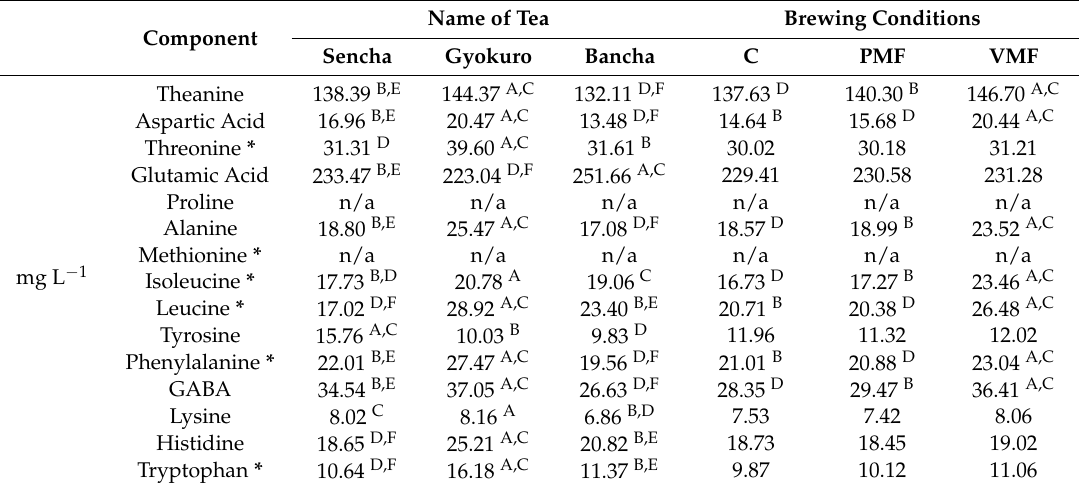
Table 2. Impact of the type of tea and manner of brewing on the content of amino acids in infusions of high-quality green tea.